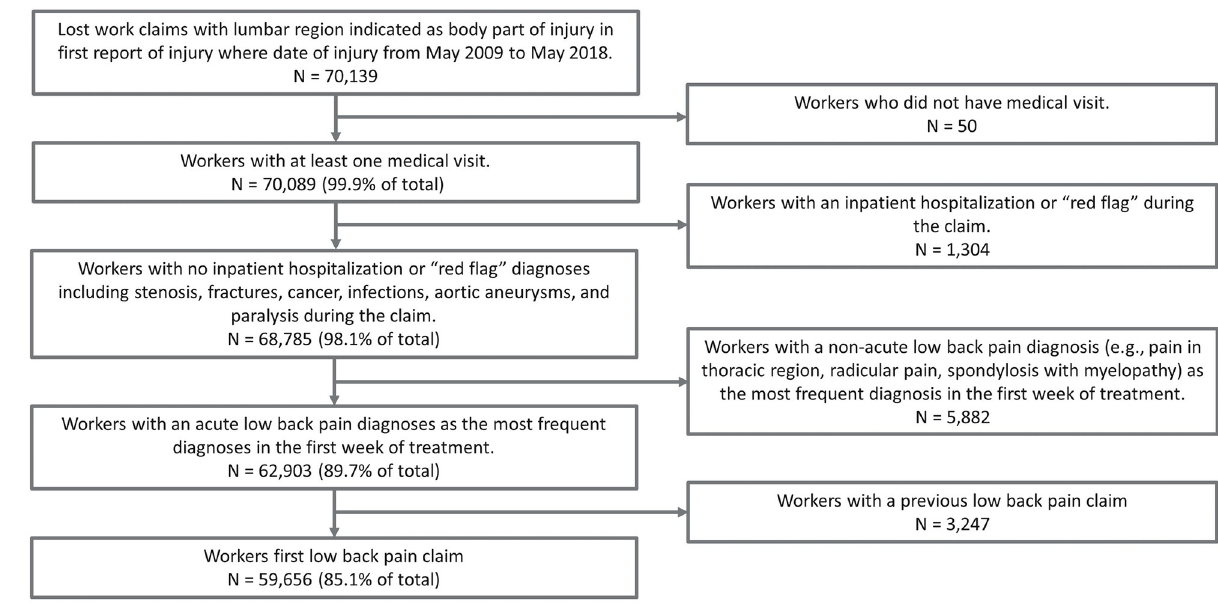
Fig 1. Flow chart depicting generation of the study